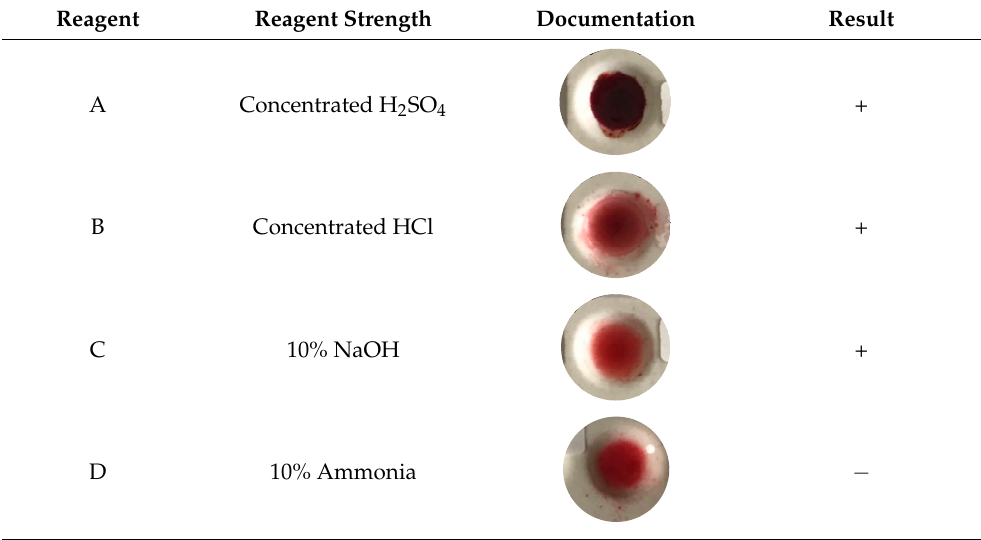
Table 1. Specific chemical reagent color change with 1000 ppm pigment red 53 standard solution.